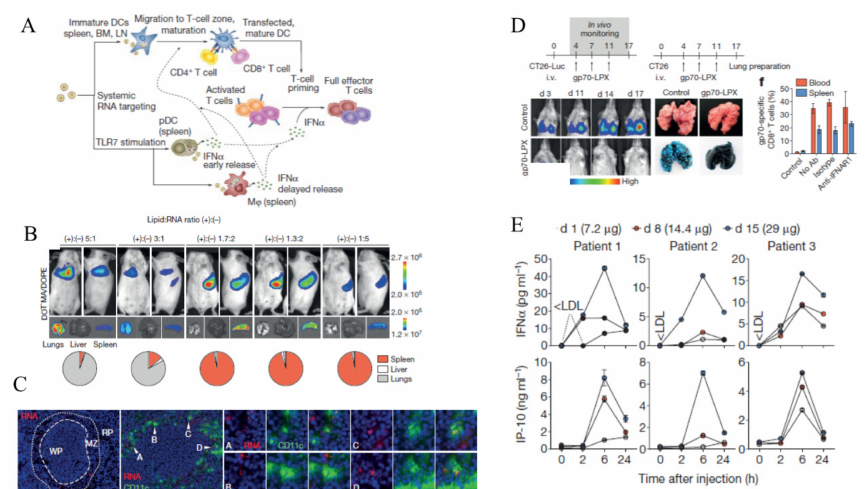
Figure 2. RNA-lipoplexes (RNA-LPX) delivery to DCs. ( A ) Mechanism action of RNA-LPX to induce anti-tumor immune responses, ( B ) Bioluminescence imaging of BALB / c mice, ( C ) Splenic localization of CD11c and Cy3 double-positive cells in BALB / c mice after 1 h of Cy3-labelled RNA-LPX i.v. injection, ( D ) in vivo studies in CT26 tumor bearing BALB / c mice immunized with gp70-LPX, and ( E ) Clinically administered RNA-LPX vaccines induce systemic INF α in dose-dependently manner. Reproduced with permission from [82]. Copyright 2016, Springer Nature.